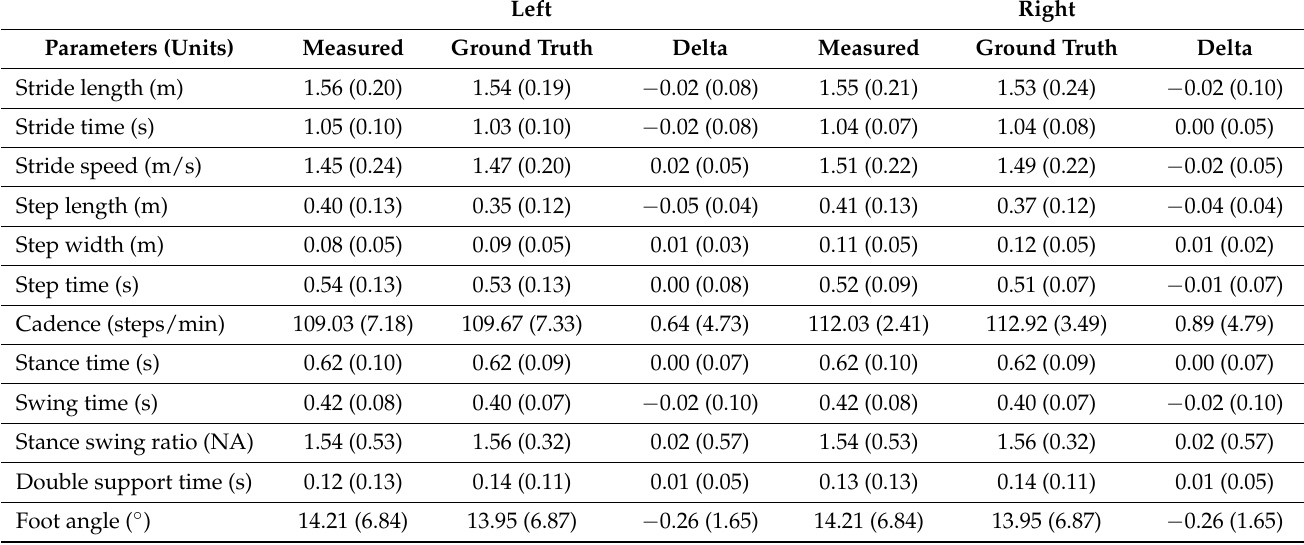
Table A8. Stride parameters for participant two: walking-turn test (mean and standard deviation in brackets). Left